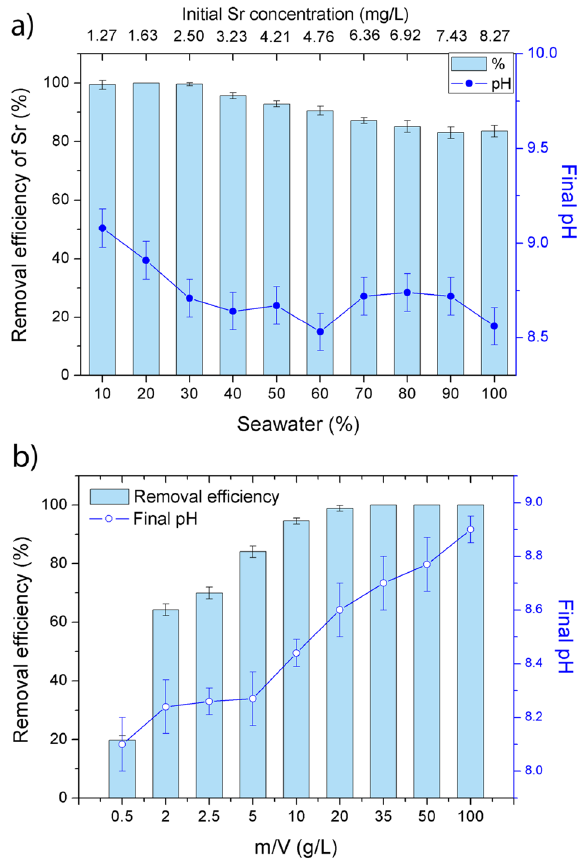
Figure 9. ( a ) The effect of seawater concentrations on the efficiency of Sr separation by Z4A ( a ), and ( b ) the effect of the solid-to-solution ratio on the efficiency of Sr removal from SW and final pH values.